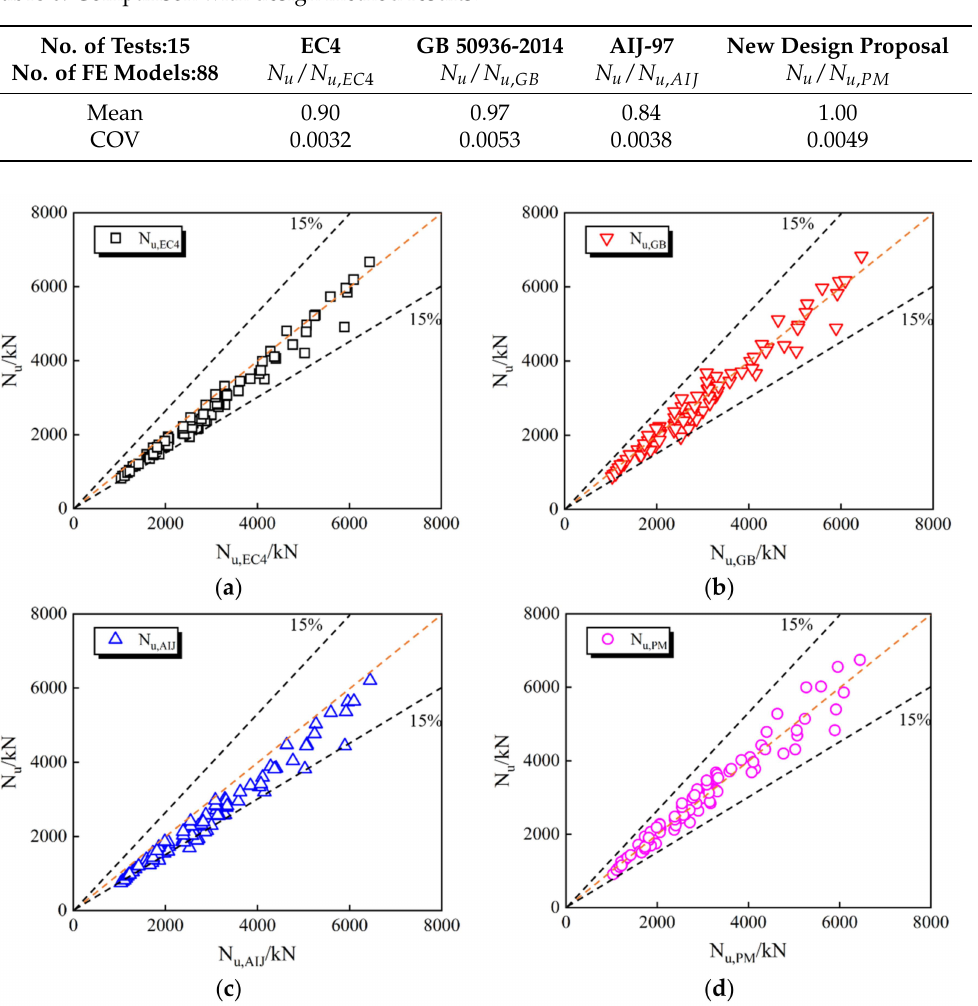
Table 6. Comparison with design method results.